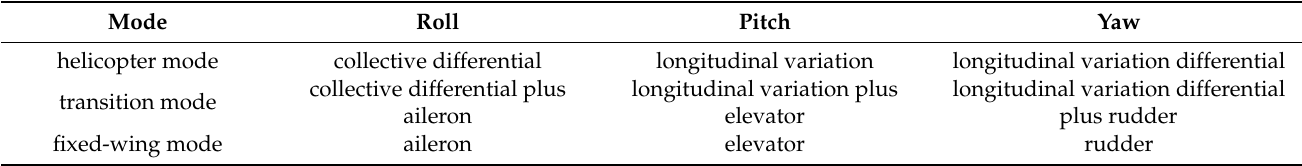
Table 3. Control strategy of the tilt-rotor